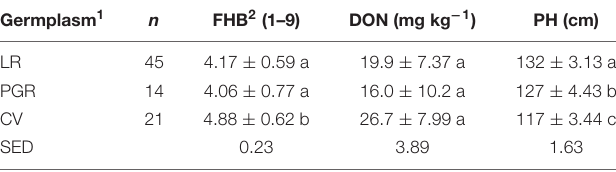
TABLE 1 | Best linear unbiased estimators (BLUEs) and their standard errors for Fusarium head blight disease severity, mycotoxin contamination of grains, and plant height of spelt germplasm from different breeding periods (Means denoted by a different letter indicate differences between genetic groups significant at p < 0.05 according to the Tukey–Kramer